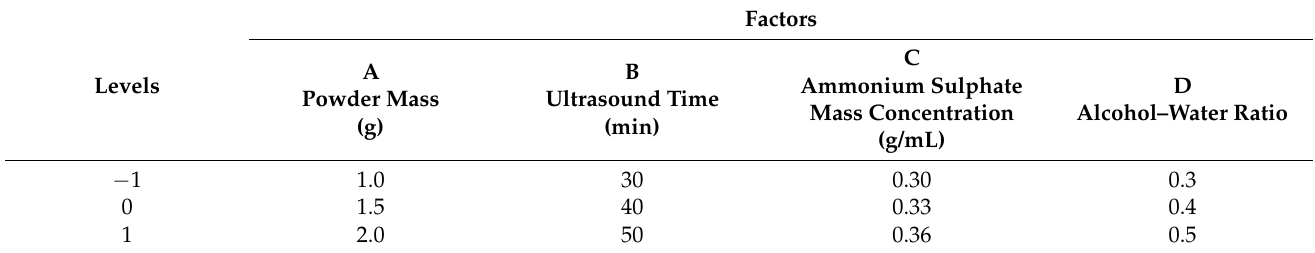
Table 1. Response surface factor